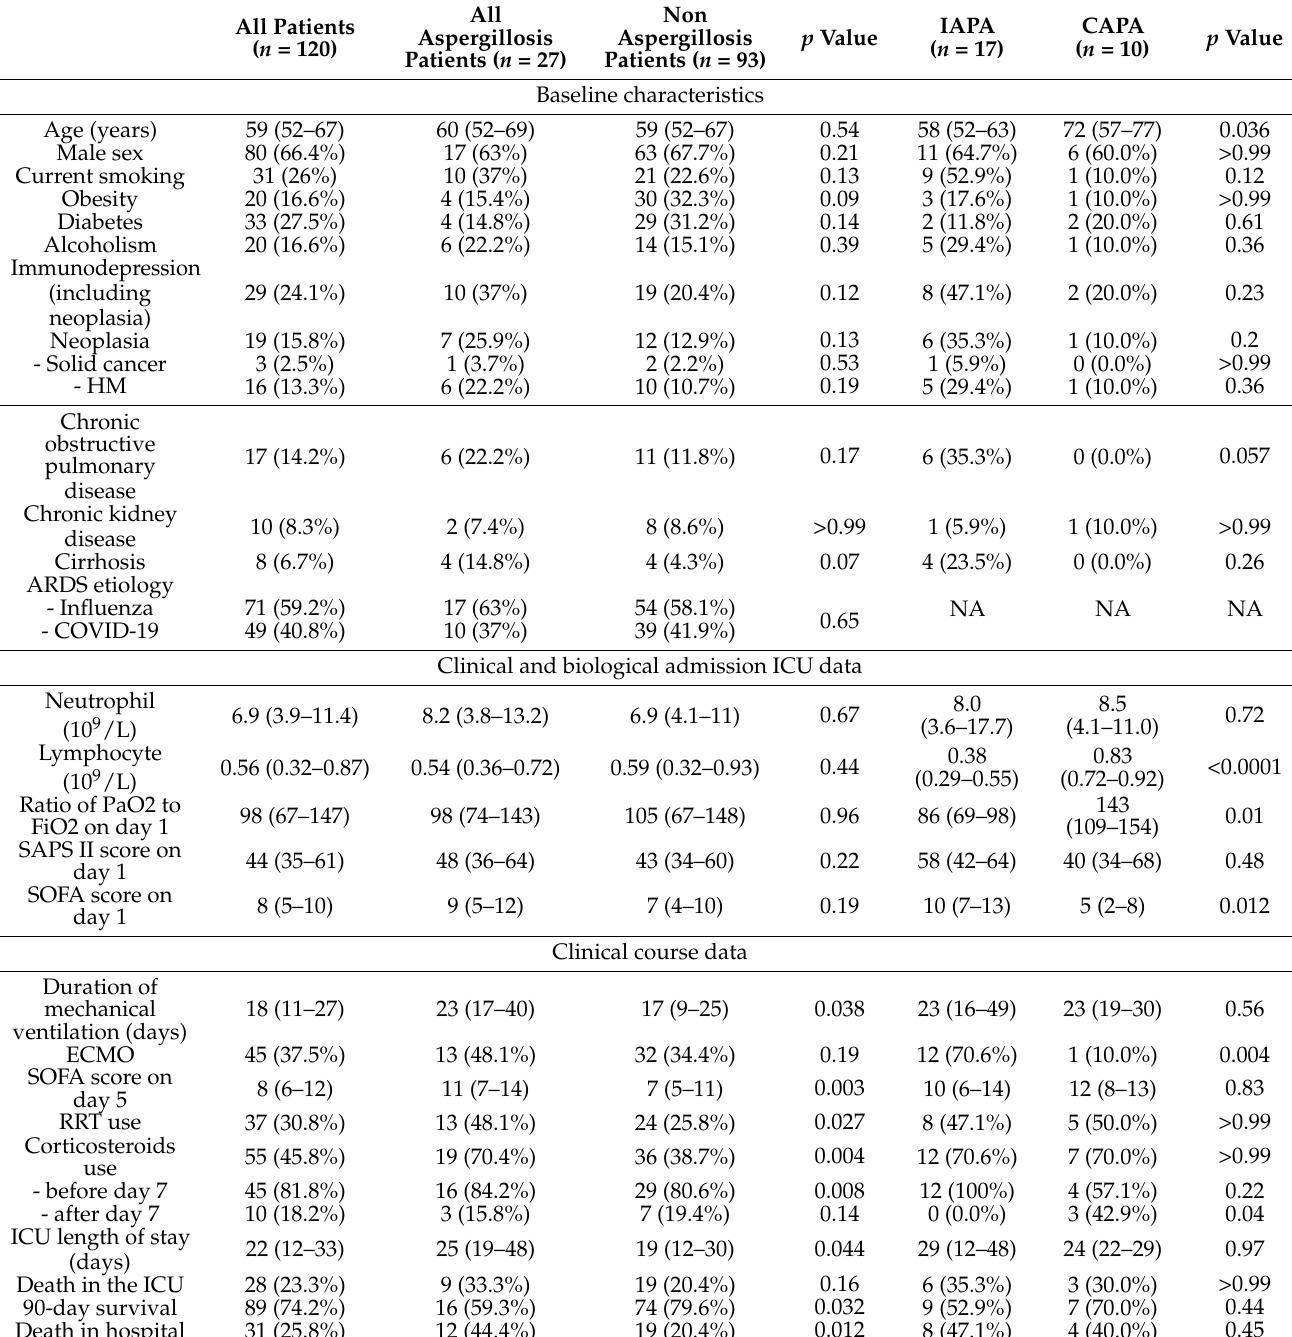
Table 1. Characteristics of patients according to aspergillosis